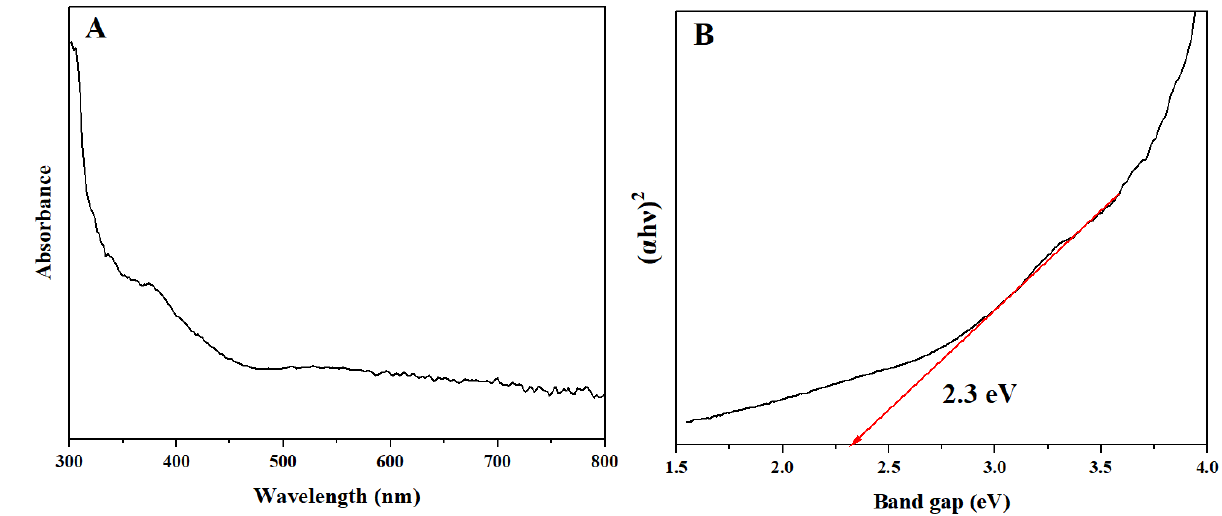
Figure 4. ( A ) UV-VIS spectra and ( B ) Tauc plot of Ag 2 CO 3 .